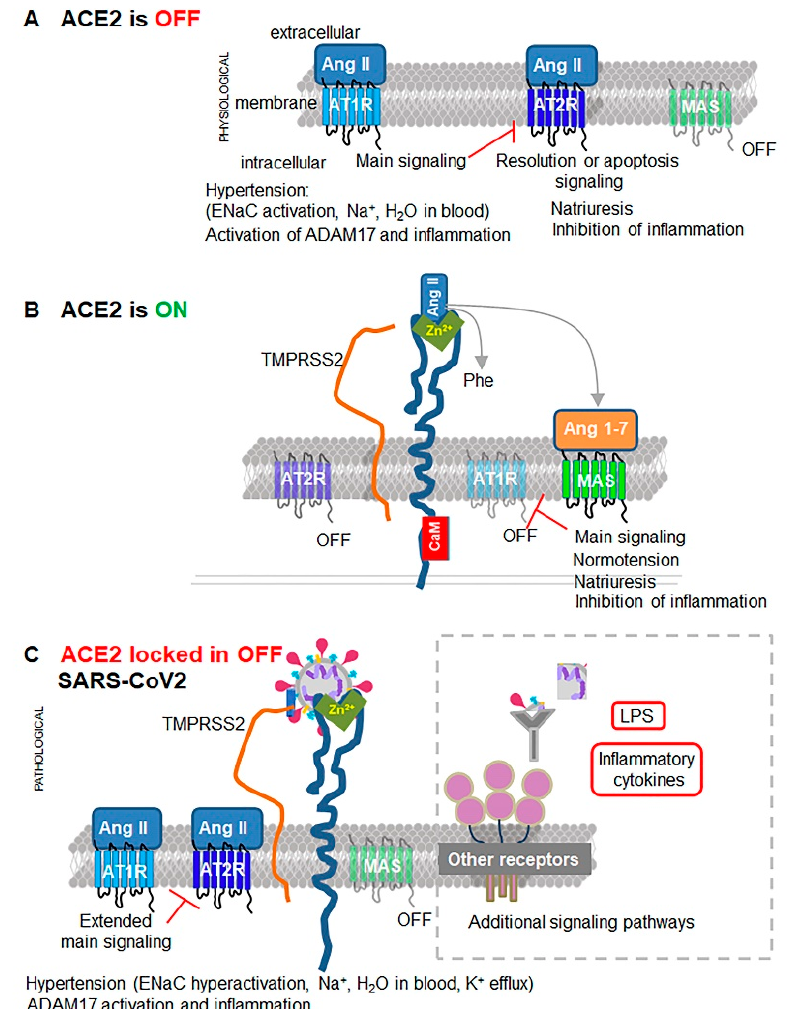
Figure 2. Schematic regulation of ACE2-dependent pathways under physiological conditions and during SARS-CoV-2 infection. ( A ) Main signaling in the absence of ACE2 when it is not expressed, or its activity is inhibited (ACE2 is ‘OFF’). Circulating Ang II binds to its high affinity G-protein-coupled receptor AT1R. Main AngII/AT1R signaling mediates vasoconstriction, NADPH oxidase activation and reactive oxygen species (ROS) formation, hypoxia induction (HIF1 α ), activation of MMPs, including ADAM17 and pro-inflammatory cytokines, Na + /H 2 O retention from extracellular fluids into blood, hypertension, hypertrophy, activation of sympathetic nerves and other effects. Ang II/AT1R receptor can suppress angiotensin 2 receptor (AT2R, red lines) expression in the initial stages of inflammation, but this suppression is alleviated by interferon regulatory factor 1 (IRF-1). Ang II also activates AT2R, sometimes in complex with different proteins, which opposes the effects of Ang II/AT1R and resolves of stress, inflammation, and apoptosis. Under specific conditions, Ang II/AT2R response could mimic Ang II/AT1R possibly by involving further cleavage of Ang II. MAS receptor remains inactivated (OFF) without ligand Ang (1–7), produced from Ang II. ( B ) The main signaling in the presence of catalytically active ACE2 (ACE2 is ‘ON’). Activated ACE2 is shown as an integral protein with an active catalytic site containing Zn 2+ in the ectodomain (green V shape). ACE2 is stabilized in a catalytically active conformation by calmodulin (CaM, red rectangle) bound to an intracellular domain of ACE2 that prevents cleavage of ACE2 by proteases ADAM17 (not shown) or TMPRSS2 (orange line shape). ACE2 cleaves Ang II, leaving both AT1R and AT2R inactive (OFF). ACE2 cleavage produces Ang 1–7, which binds to MAS receptor and elicits signaling that opposes Ang II/AT1R effects and inhibits AT1R expression (red lines). ( C ) SARS-CoV-2 (circular shape) binds to the catalytic site of ACE2 for entry. SARS-CoV-2 has also acquired a new sequence that mimics the furin cleavage site of human ENaC (blue cylinder inside viral shape). TMPRSS2 is an inhibitor of ENaC; however, in the presence of SARS-CoV-2, it possibly binds to ENaC mimetic site for cleavage of viral spike proteins for replication. Host ENaC remains active (not shown). The resultant